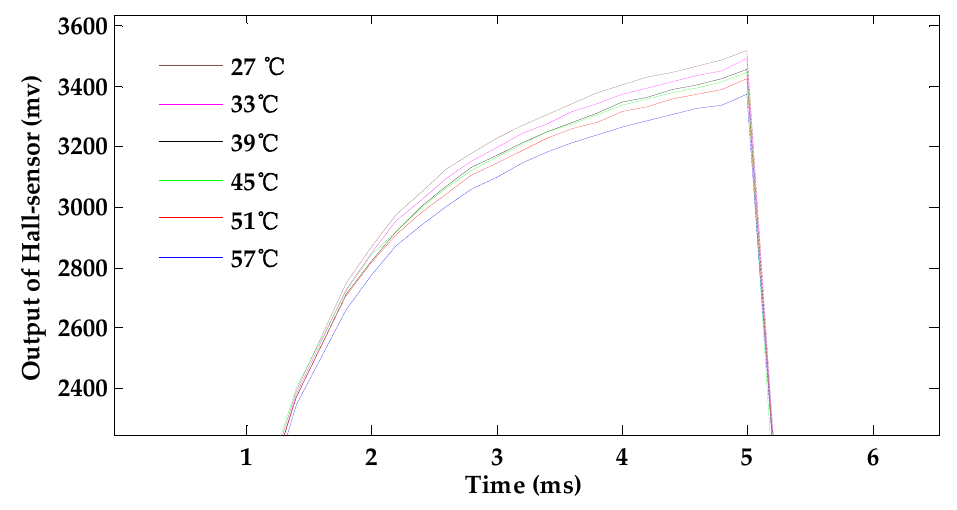
Figure 4. The effect of temperature rises in the exciting coil on the testing signal.